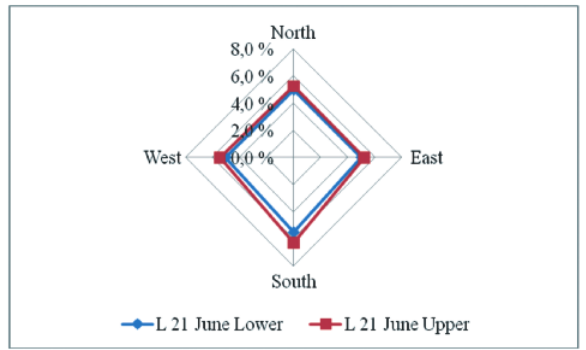
Fig. 12: Stone-pulp ratio in the function of orientation and height in the case of Linda [%]